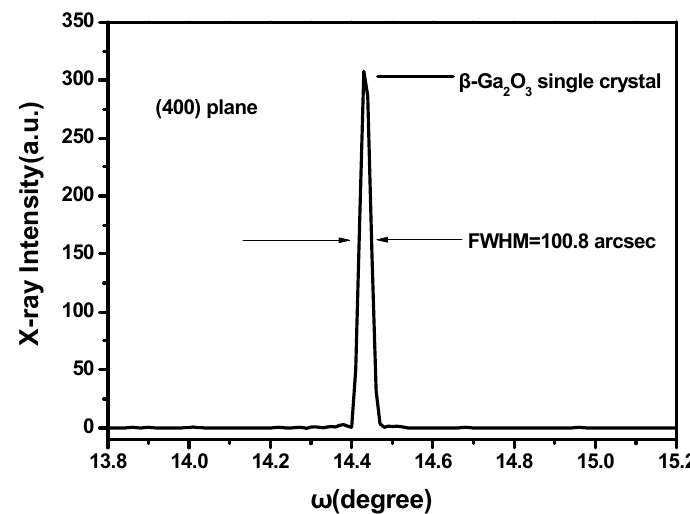
Figure 2. X-ray rocking curve of the β -Ga 2 O 3 single crystal ((400) plane).